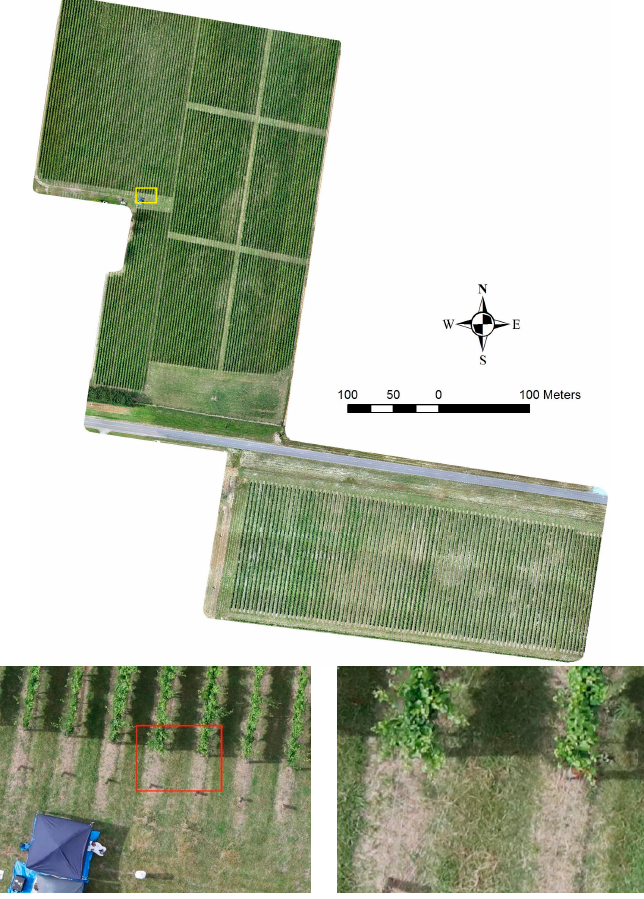
Figure 6. Generated orthomosaic of studied sites; two vineyards in the Yarra valley, Victoria, Australia. Bottom images show enlarged regions of the vineyard with clearly visible plants.